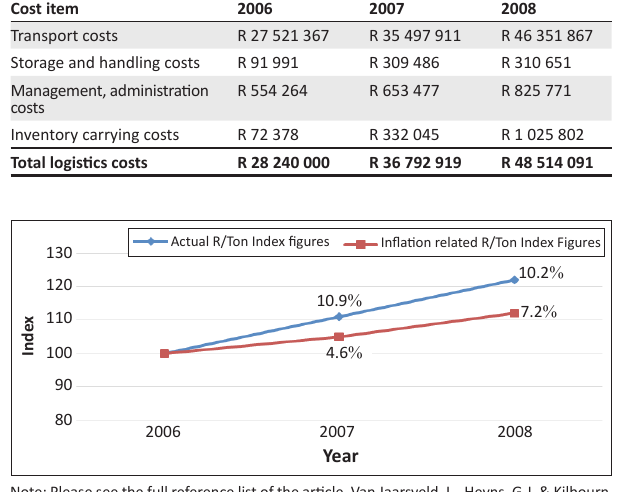
FIGURE 5: Actual rand/ton rates versus inflation related rand/ton rates.